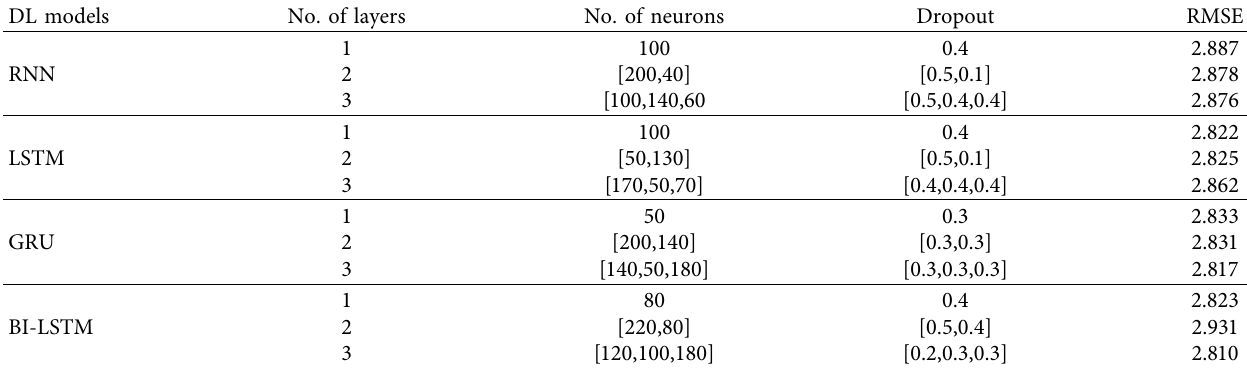
Table 3: The result of DL models for lag of 5 minutes and forecasting 7 minutes in